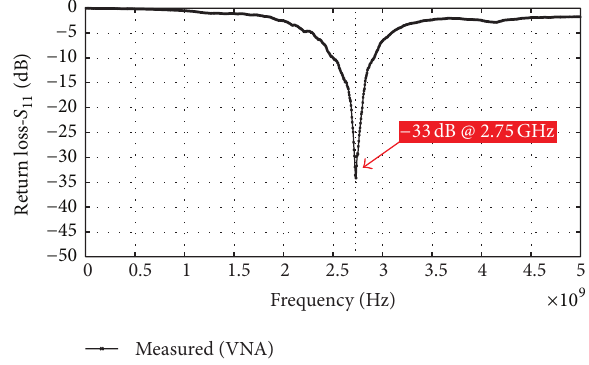
Figure 2: Measured return loss of the PIFA